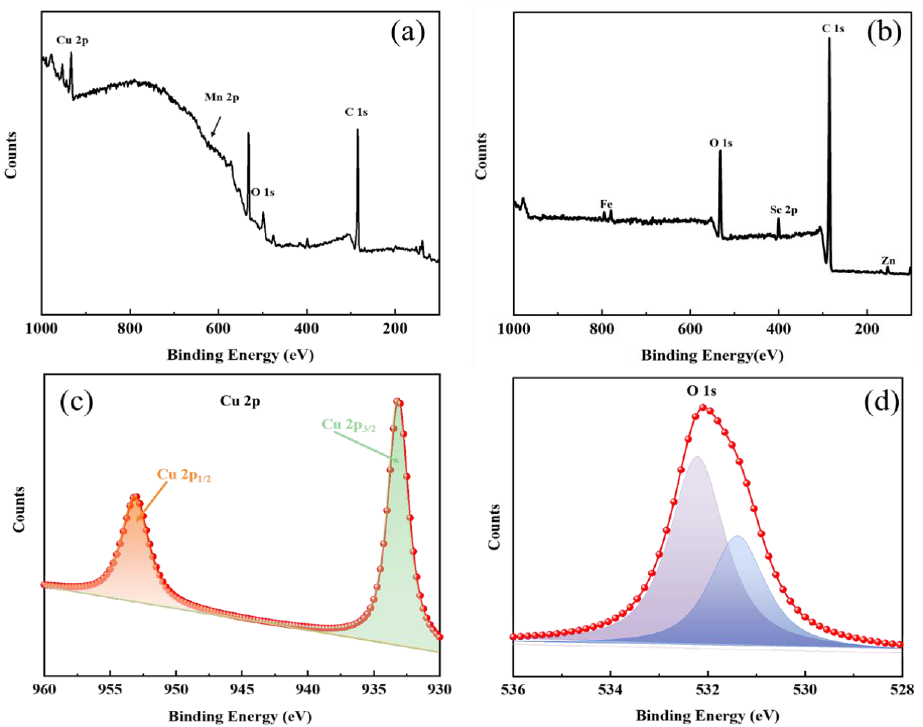
Figure 12. XPS spectrum of sample Mn-Cu ( a ) and Fe-Zn ( b ), Cu 2p ( c ) of Mn-Cu sample and O 1s ( d ) of Mn-Cu sample.